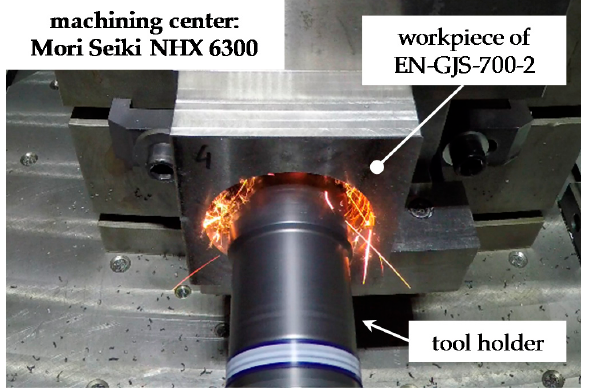
Figure 8. Drastic wear effects due to dry machining with a PCD cutting insert.